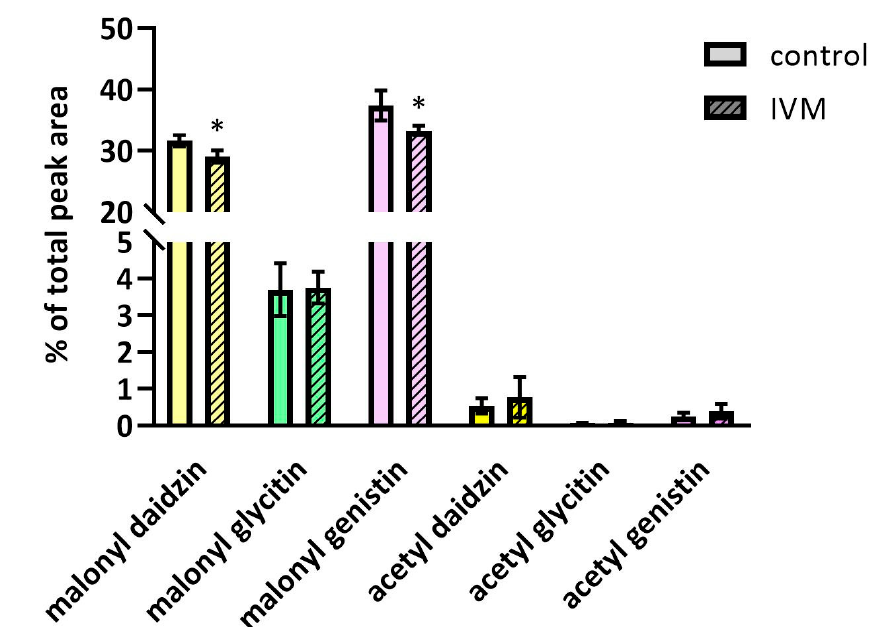
Figure 5. The quantity changes of malonylated and acetylated forms of daidzin, glycitin and genistin under IVM exposition. Data are expressed as mean ± SD ( n = 6). * indicates statistically significant difference between treated and control plants.Although IVM has been shown to increase the total polyphenol content in soybean seeds, it reduced the content of isoflavones aglycones, which are considered as more effective in preventing certain hormone-dependent and other diseases [26]. Thus, the presence of IVM in manure, and subsequently in soybeans, may decrease the therapeutic value of soybean.